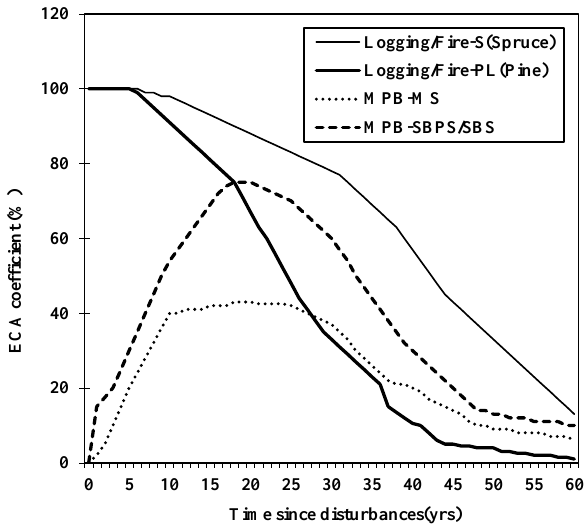
Figure 4 Equivalent clear-cut area (ECA) coefficients for the Baker Creek watershed 941 Fig. 4. Equivalent clear-cut area (ECA) coefficients for the Baker Creek watershed.